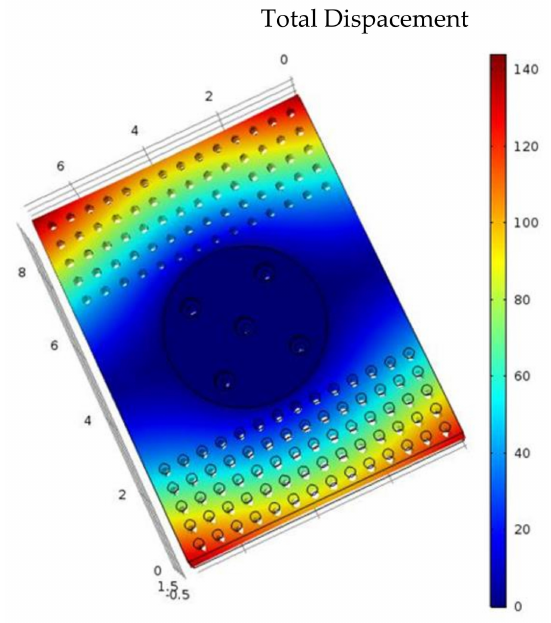
Figure 6. The first mode shape of the baseplate happens at 2716.3 Hz. Table 4. The first six natural frequencies of the baseplate. Frequency No. Natural